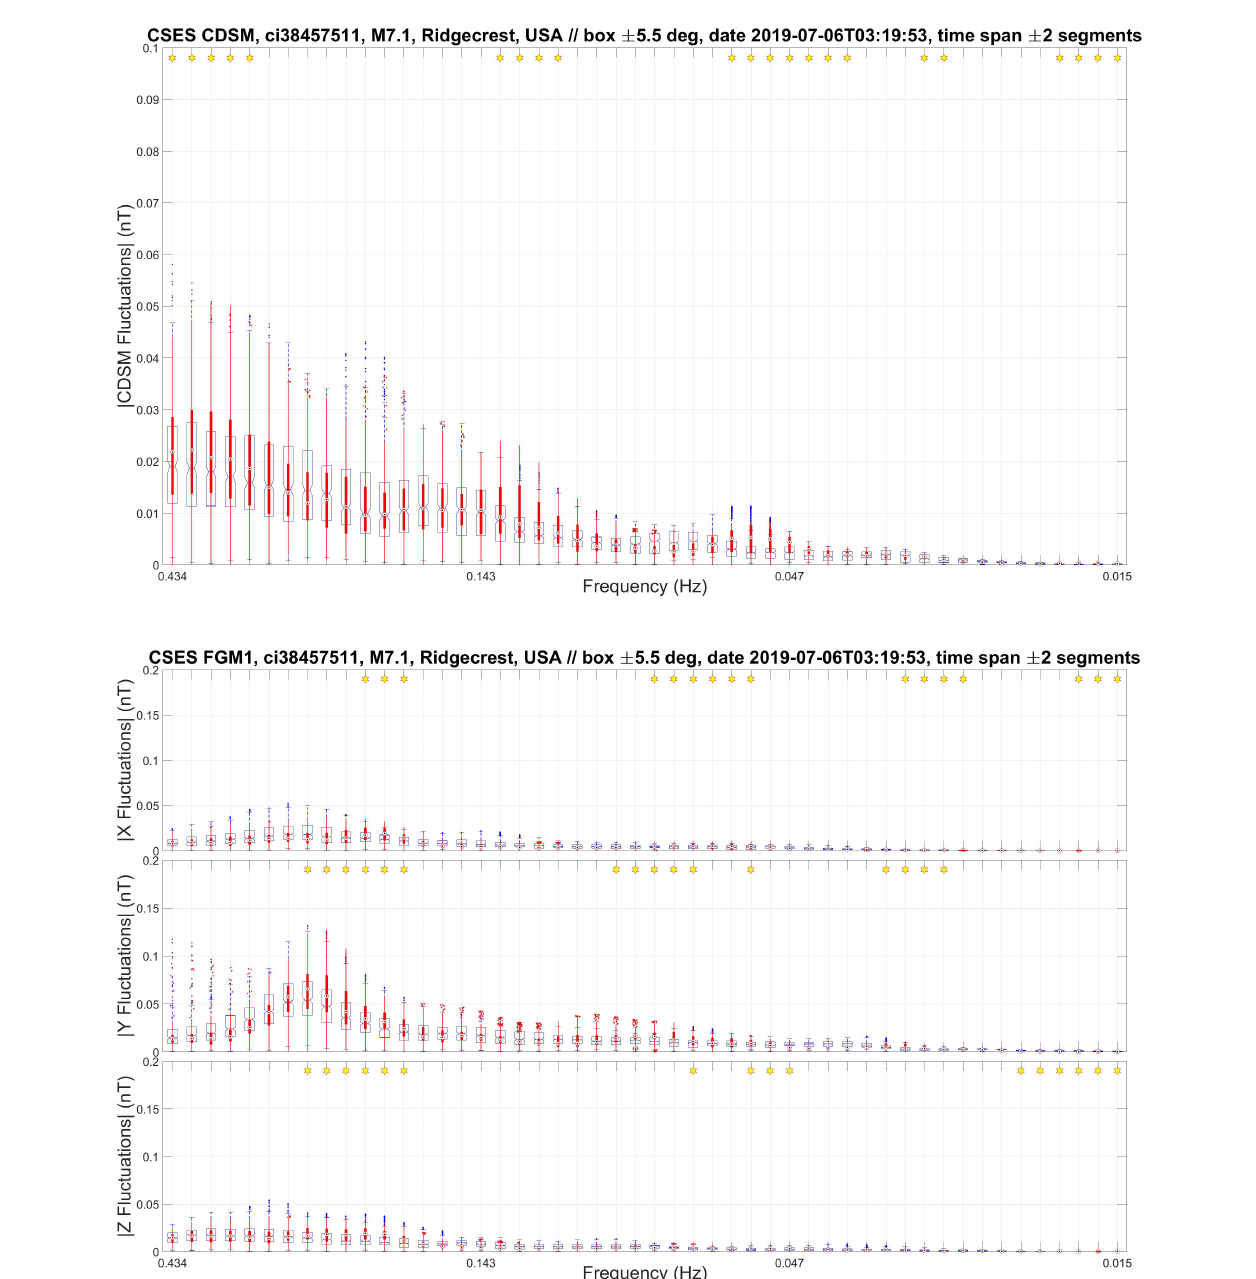
Figure 6. CSES investigation of the earthquake USGS event ci38457511 with magnitude M7.1, Ridgecrest, USA, focal depth 8 km, with a spatial dimension (box size) of ± 5.5 degrees, only crossings during night times are considered. Top : Distribution of CSES CDSM magnetic field fluctuations grouped in individual frequency bands. CDSM is found to display a wavelike behaviour. The time span around the EQ is ± 2 segments, i.e., in this case ∆ t = { − 4.73, − 3.75, − 2.76, 0.27, 1.25} days shift to the EQ at 2019-07-06T03:19:53. Bottom : Distribution of the CSES FGM1 magnetic field fluctuations after wavelet analysis. The colour coding is the same as in Figure 2, geomagnetic activity is | Dst | ≤ 17 nT for the selected time